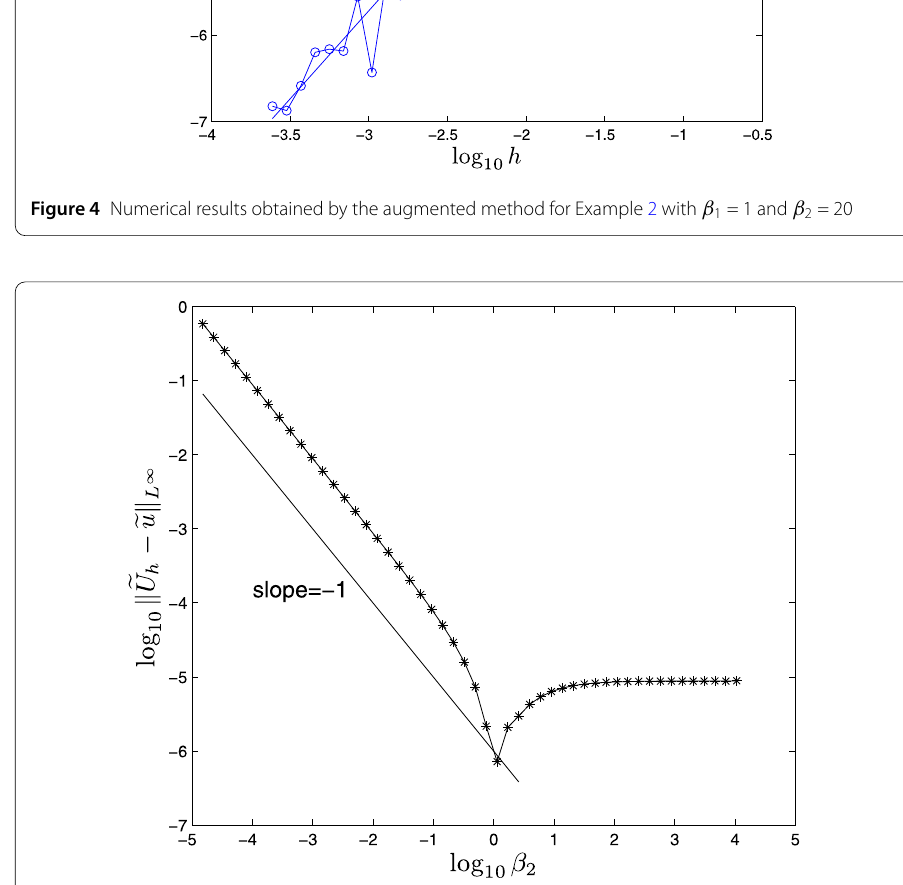
Figure 5 Numerical results obtained by the augmented method for Example 2 with β 1 = 1, N =